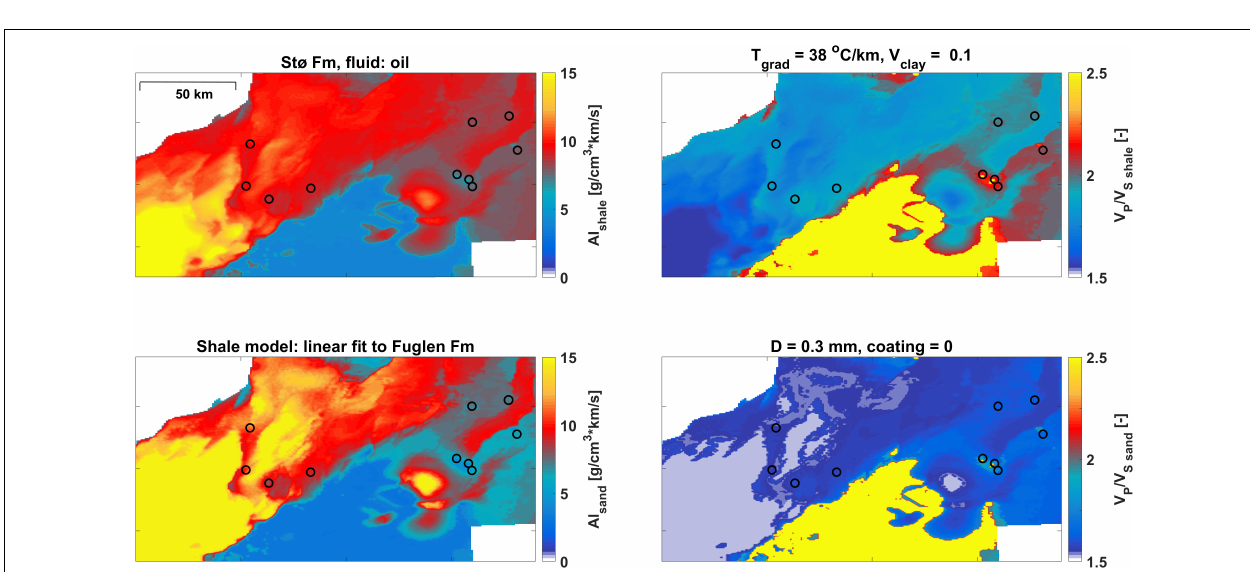
FIGURE 8 | Empirical shale trends. Models for separate shale intervals are shown from left to right , comprising Kolje, Fuglen, and Fruholmen Fm-s. Regression lines are also made for all shale intervals together (rightmost subplot). Published trends by Hjelstuen et al. (1996) and Japsen (1999) are superimposed.